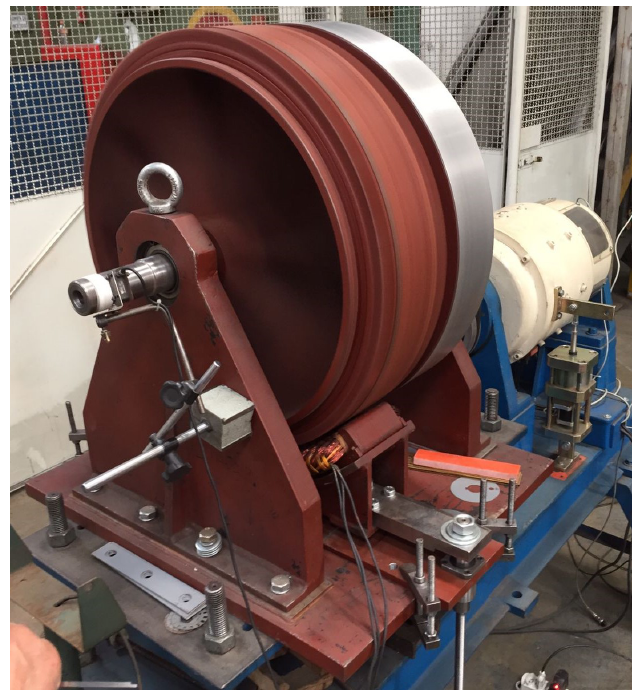
Figure 10. Prototype on test bench.